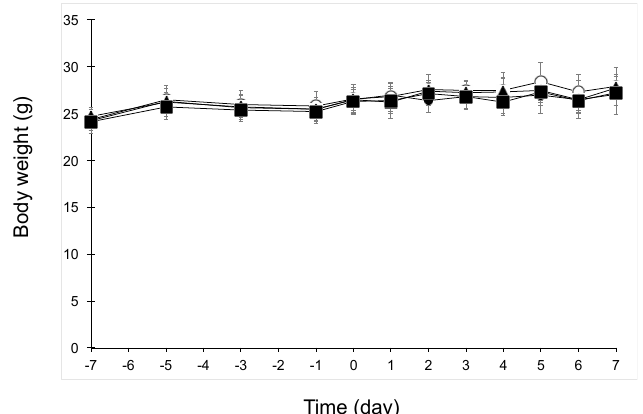
Figure 1. Body weight changes in UVB-irradiated mice after oral administration of beet GlcCer or beet extract. Symbols and bars represent means and standard deviation ( n = 6 from day − 7 to day 3, and n = 3 from day 4 to day 7), respectively. Symbols: Closed circles, Normal group (without UVB irradiation, vehicle administration); Open circles, Control group (200 mJ/cm 2 UVB, vehicle administration); closed triangles, beet GlcCer group (200 mJ/cm 2 UVB, beet GlcCer oral administration); closed squares, beet extract group (200 mJ/cm 2 UVB, beet extract oral administration).